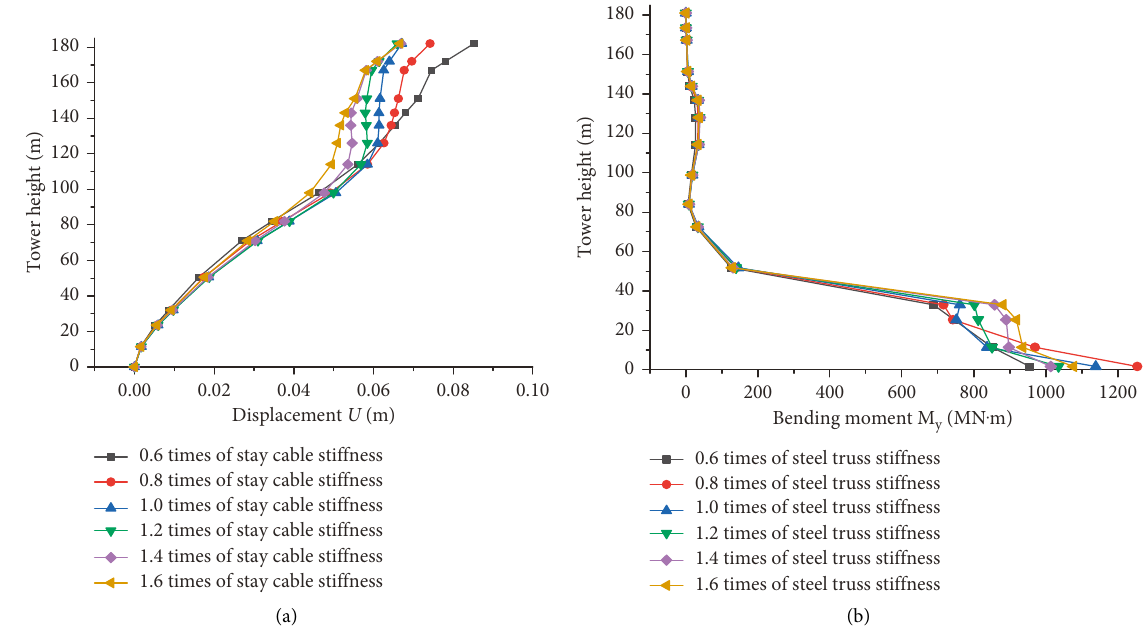
Figure 7: Distribution of maximum displacement U and maximum bending moment My along with the tower height for bridges with different multiples of steel joist stiffness under earthquake action. (a) Distribution of the maximum value of the bridge tower displacement and (b) distribution of the maximum value of the bridge tower bending moment.